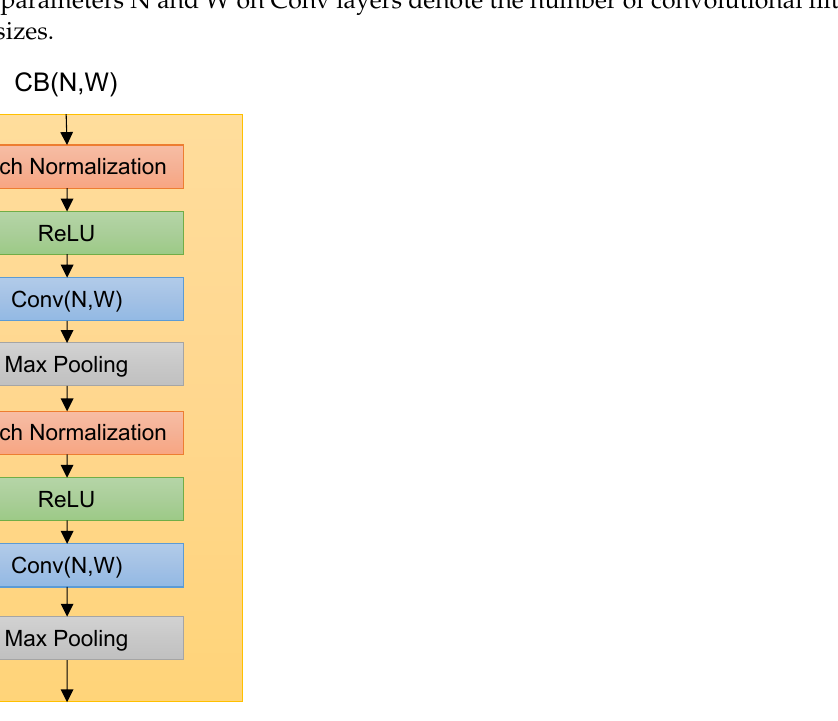
Figure 2. The Convolutional Block (CB) structure contains Batch Normalization, ReLu, Convolutional (Conv), and Max Pooling layers.